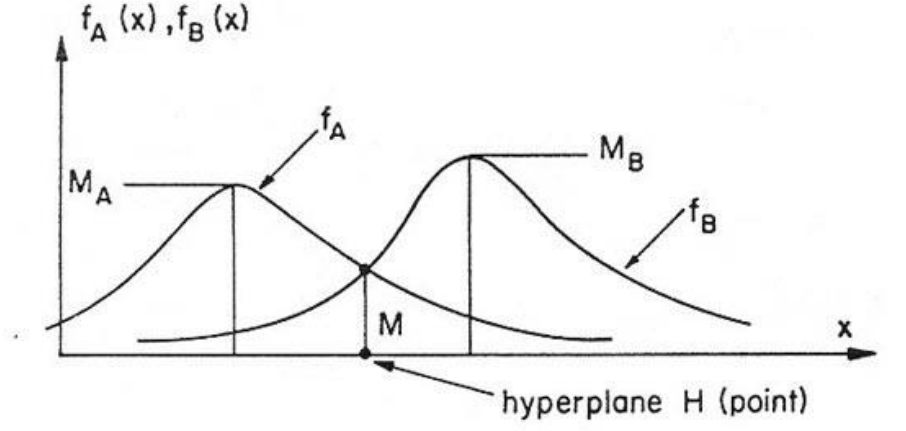
Figure 9. Illustration of the separation theorem for fuzzy sets in E 1 [25].